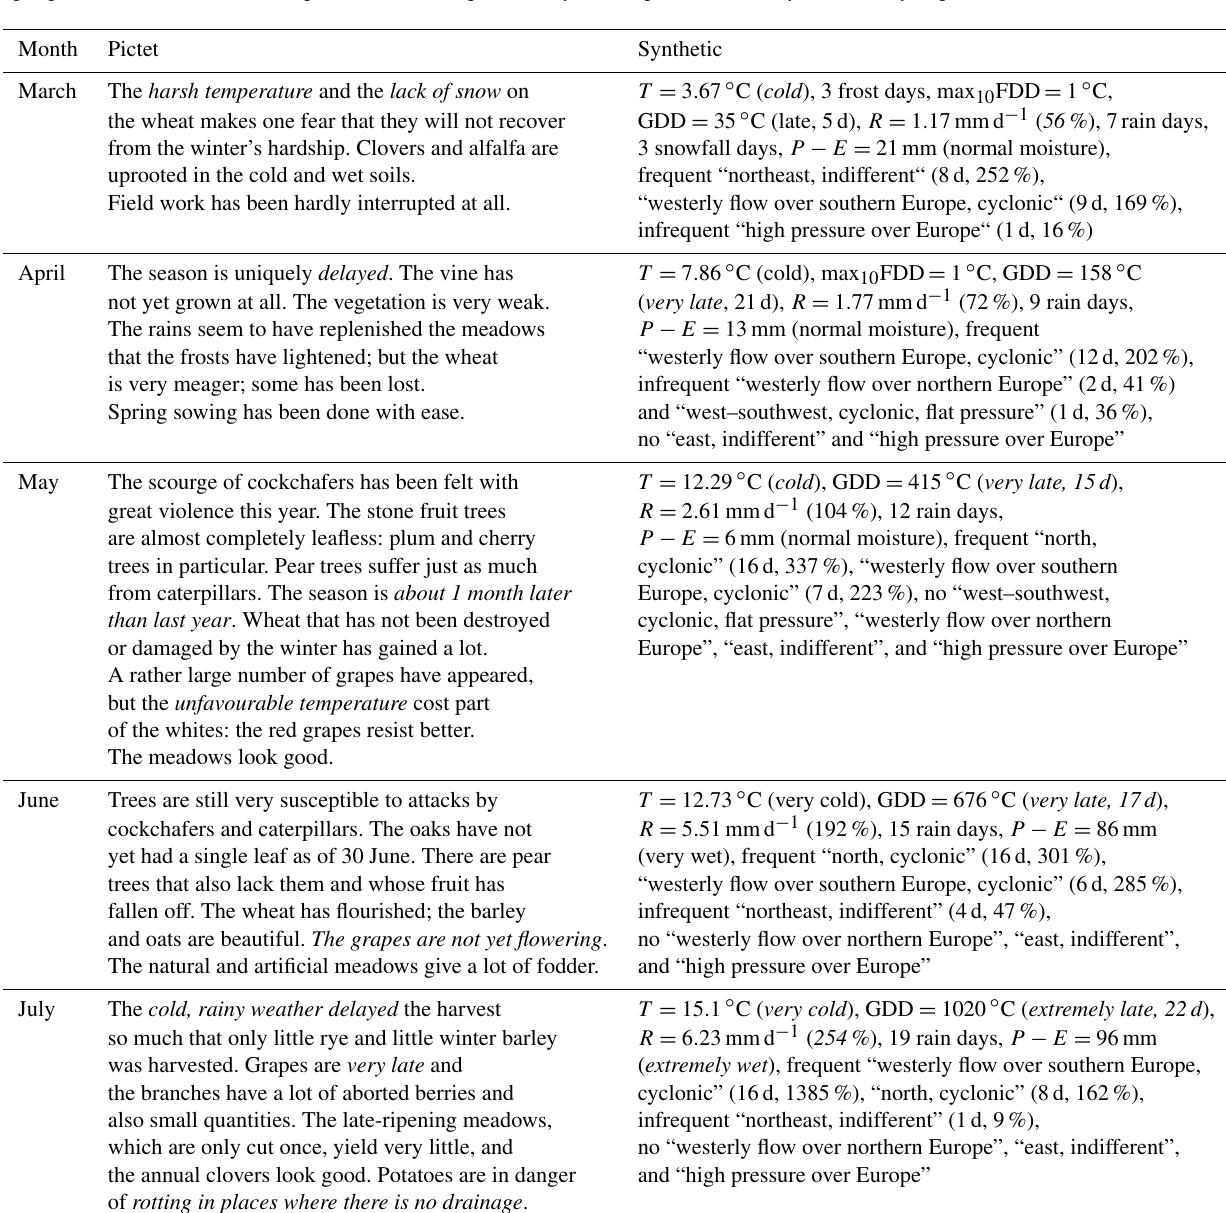
Table 5. Comparison of monthly summaries of weather and state of vegetation by Pictet (1816) in Geneva (my translation) and in our synthetic weather diary (excerpt giving monthly mean temperature, number of frost days (if any), max 10 FDD, GDD, delay, monthly mean rainfall, percentage of normal rainfall, number of rain and snowfall days, P − E with qualifier, overview of frequent ( > 150%) and infrequent ( < 50% relative to expected frequency from reference period) weather types, with number and percentage compared to reference period). Highlighted in italics are text excerpts (left) that can qualitatively be compared with the synthetic diary